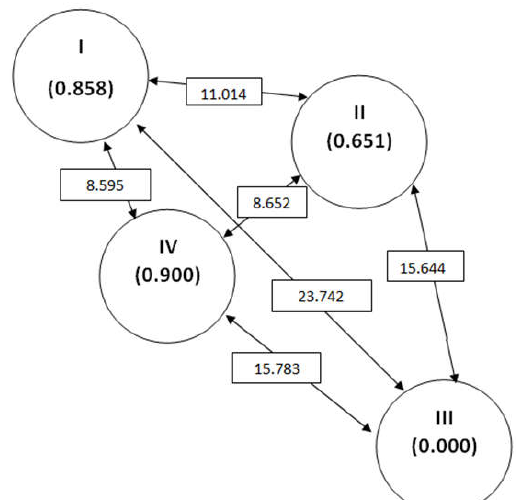
Fig. 3. Nearest and farthest clusters in kidney bean